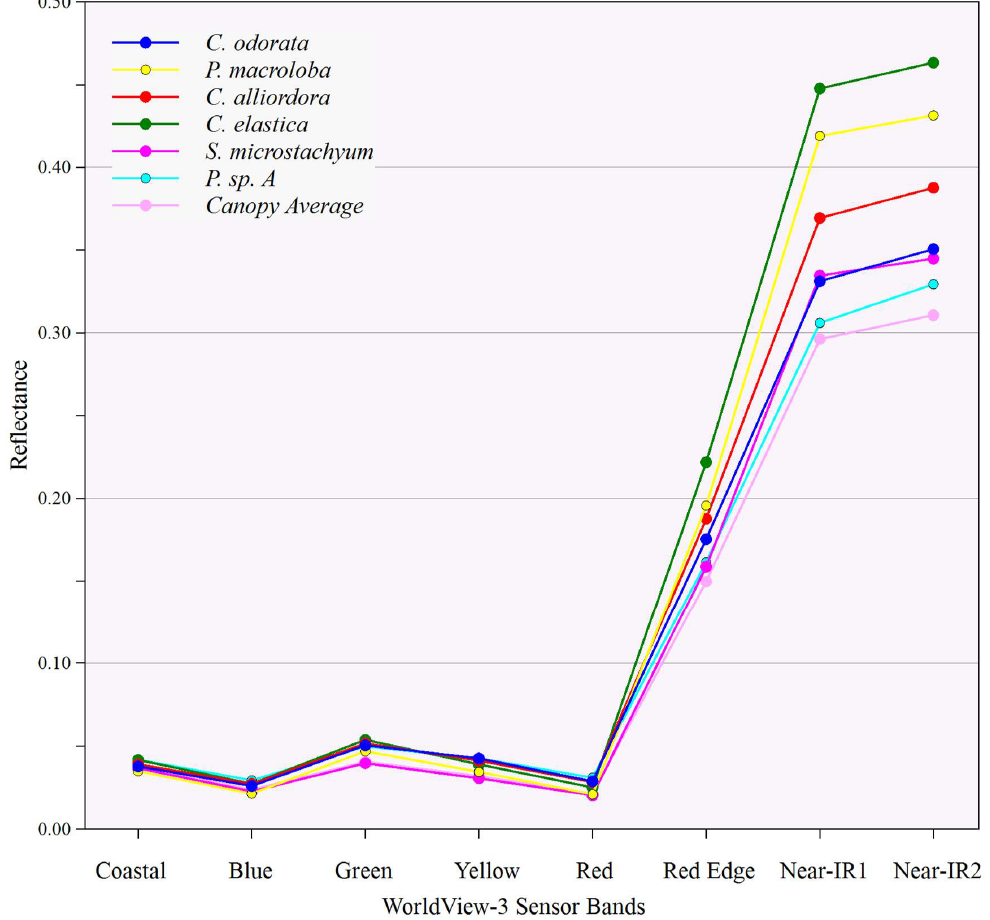
Figure 4. Average reflectance of the six tree species used as ground truth for this study. Canopy Average values for the Arboretum area also included. Lines between points are for clarity to show the trend in variability between bands.